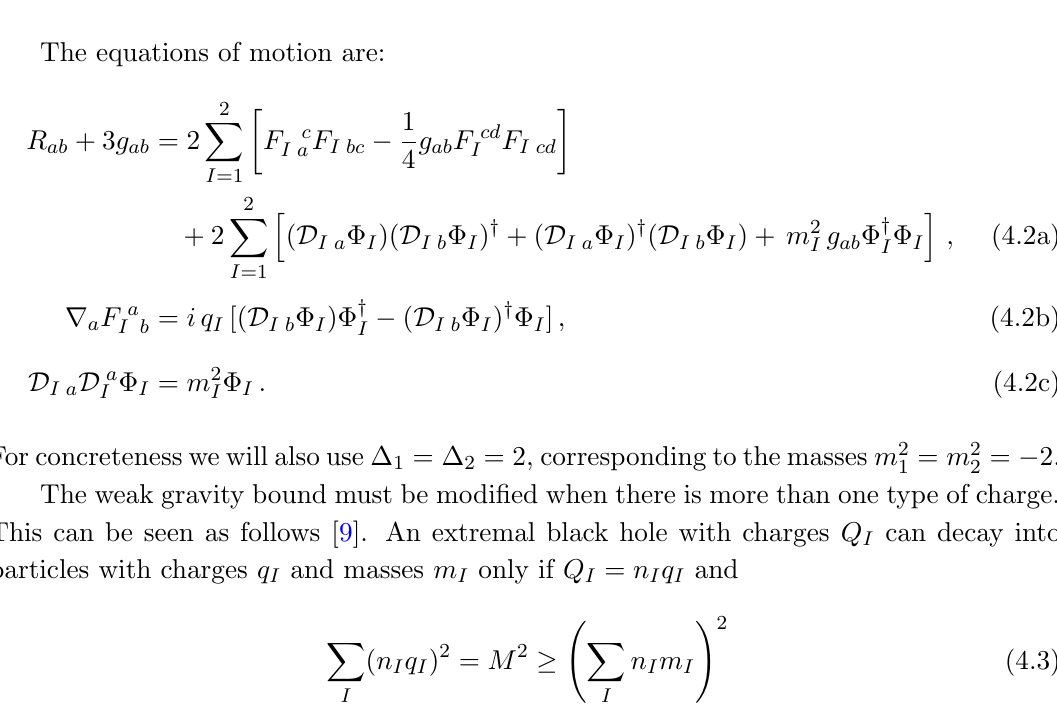
Figure 7 . Approach to the singular solution for (cid:12)xed (cid:11) = 1, and a = 10: for a small range of q , there is a two-fold